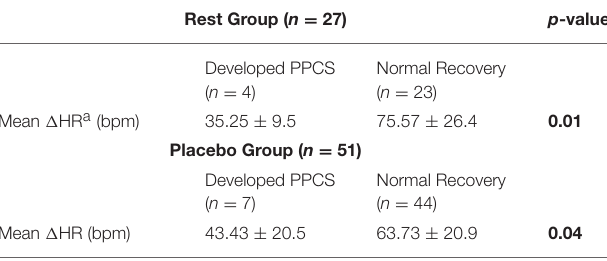
TABLE 3 | Mean heart rate of participants who developed persistent post-concussive symptoms.